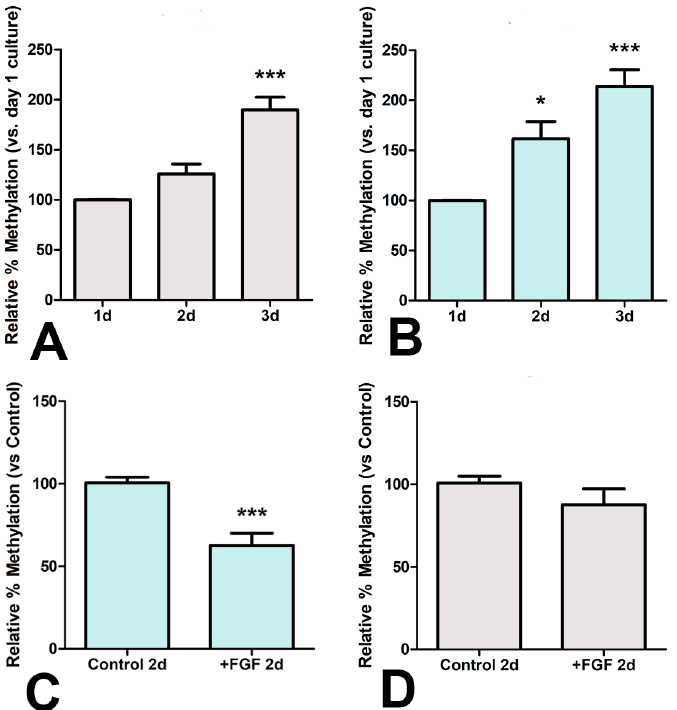
Figure 4. ( A , B ) Changes in the rate of cytosine methylation of the Scleraxis ( A ) and Sox9 ( B ) promoters during the first three days of micromass culture. ( C , D ) Changes in the rate of cytosine methylation of the Sox9 ( C ) and Scleraxis ( D ) promoters during the first two days of culture induced by the addition of FGF2 (25 ng/mL) to the culture medium. * p < 0.05; *** p < 0.001.